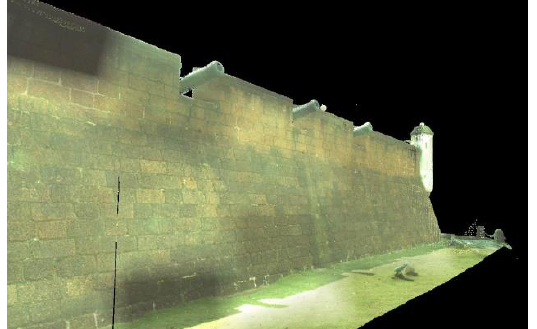
Figure 7. The coloured point cloud data of the side part of the monument